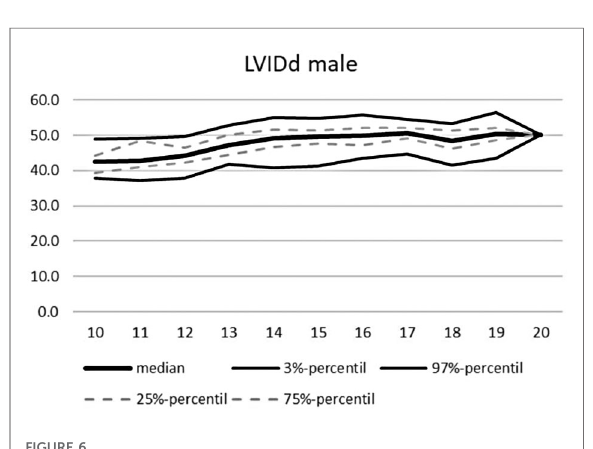
FIGURE 6 Echocardiographic values in dependence of age, LVIDd male.